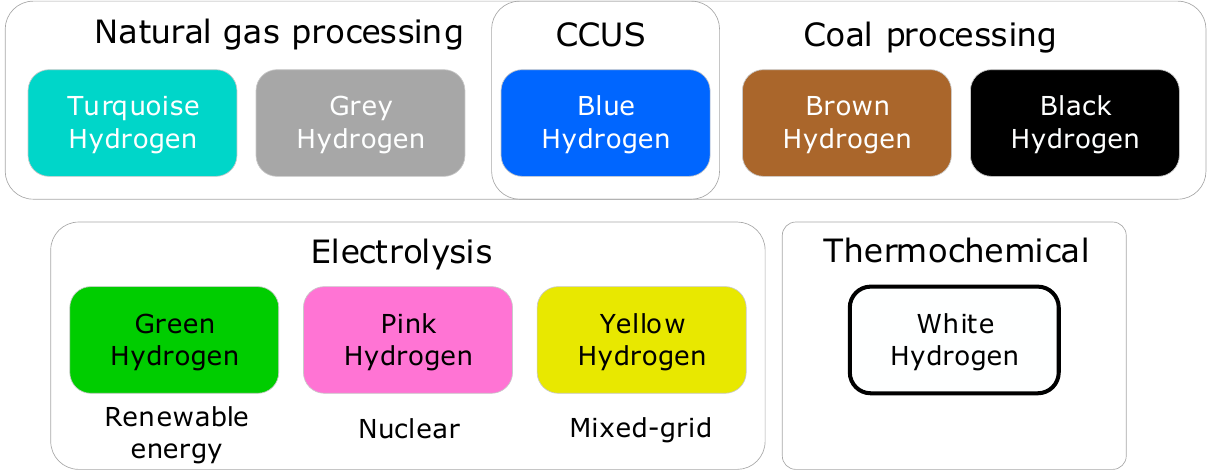
Figure 1. Hydrogen color-based classification methodology.